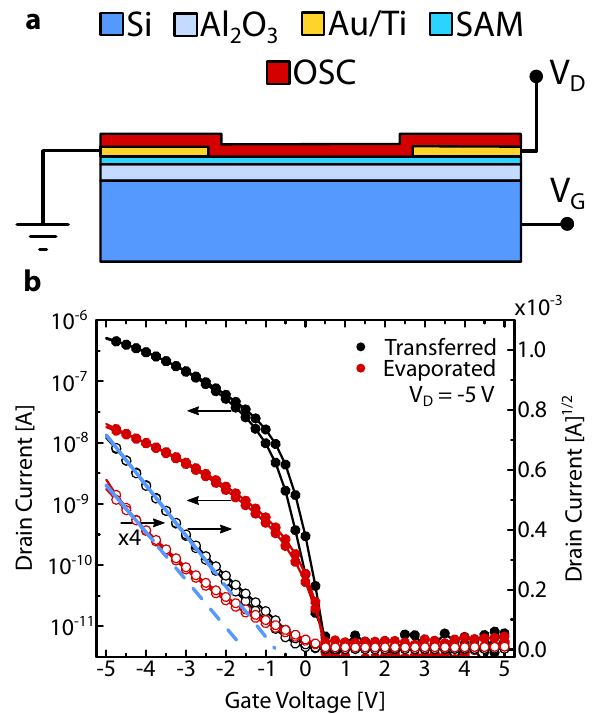
Fig. 3 Electrical characterization of DNTT FETs. a Schematic of OSC nanosheet FET device. The Si device substrate has a